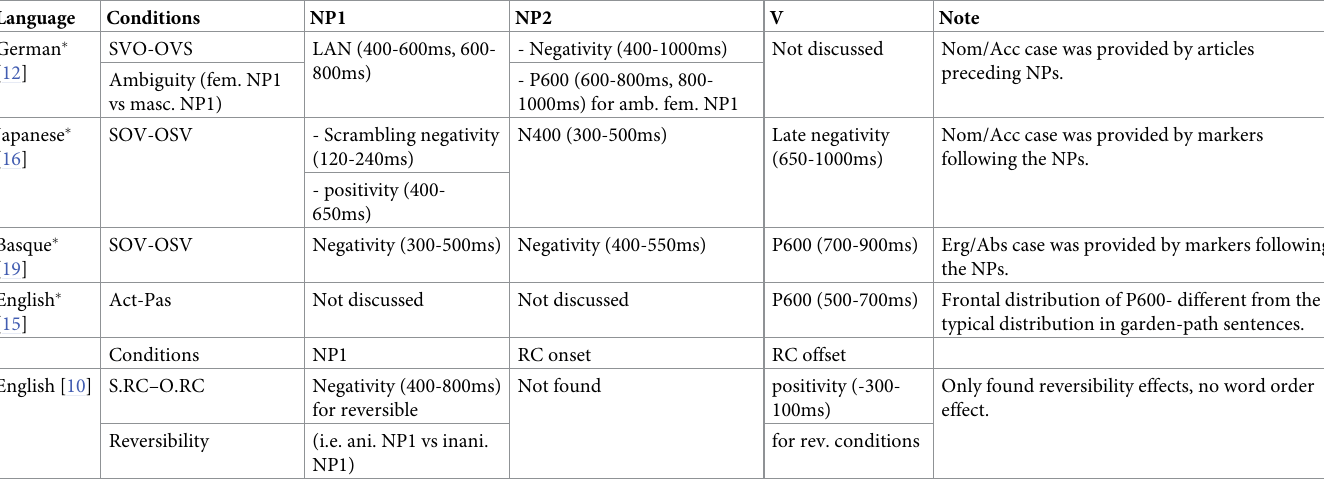
Table 1. Summary of previous ERP studies comparing word